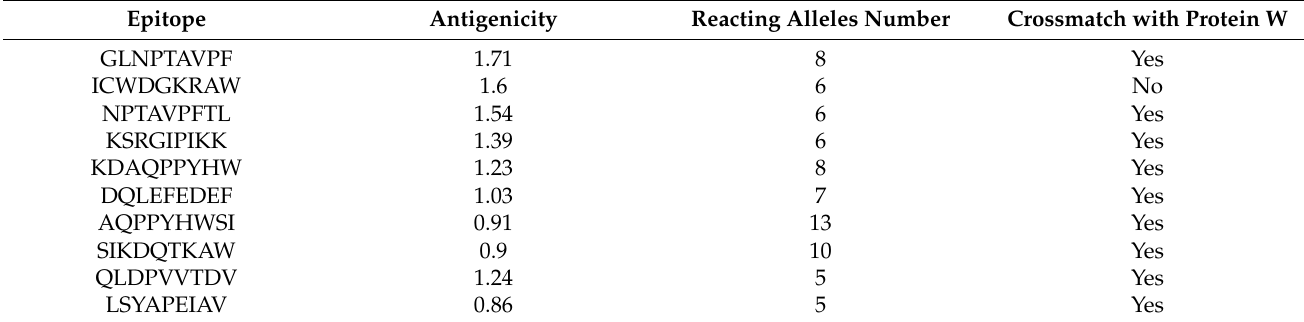
Table 5. Top-ranked T cell epitopes (MHC-I peptides) of V protein.